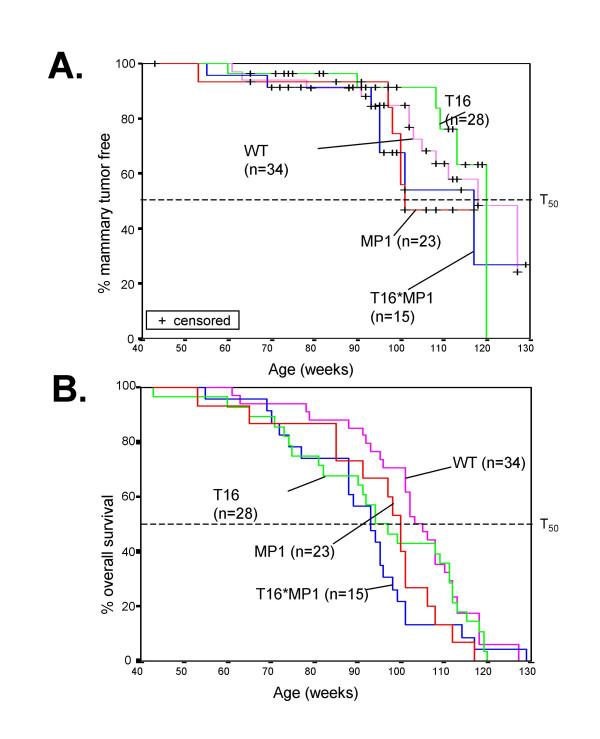
Tumor incidence in transgenic mice. (A) Kaplan-Meier analysis of the occurrence of mammary gland tumors in female wild type (WT), cortactin transgenic (T16), cyclin D1 transgenic (MP1) and cortactin/cyclin D1 bitransgenic (T16*MP1) mice as indicated by % mammary tumor free. No significant differences were seen. The age at which 50% of the animals were found to have mammary gland tumors, the T50, is for each mouse line more than 100 weeks. n, number of mice examined; +, indicates those mice that died without a MG tumor (censored). (B) Kaplan-Meier analysis determining the survival ratio of wild type and transgenic mice. MP1 and T16*MP1 were significantly different from WT (p = 0,034 and p = 0,017 respectively, log-rank test).